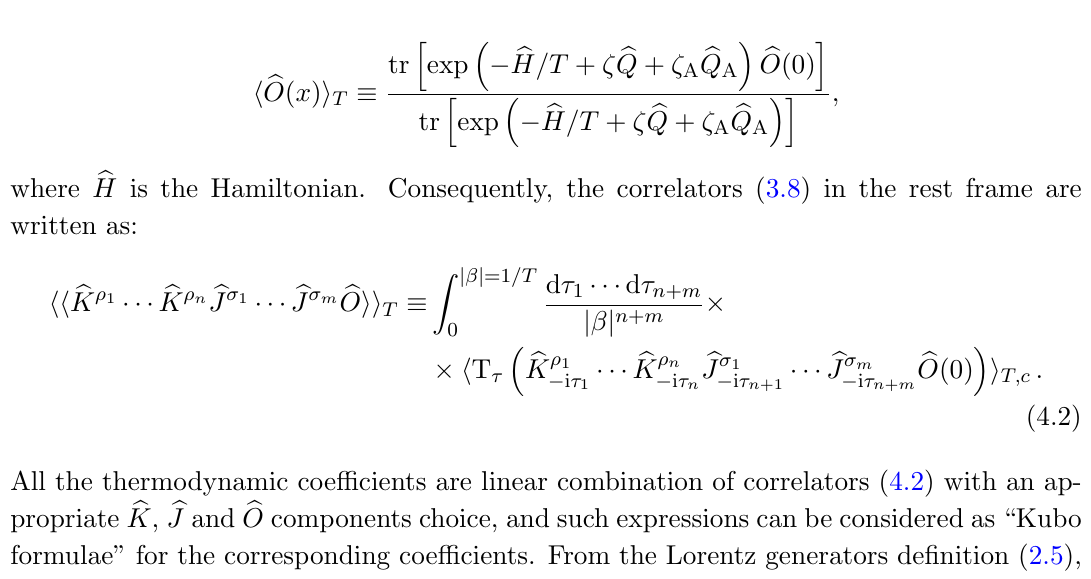
j µ is an axial current, φ is a scalar and φ A A Q and Q A are vector and axial charge b b b